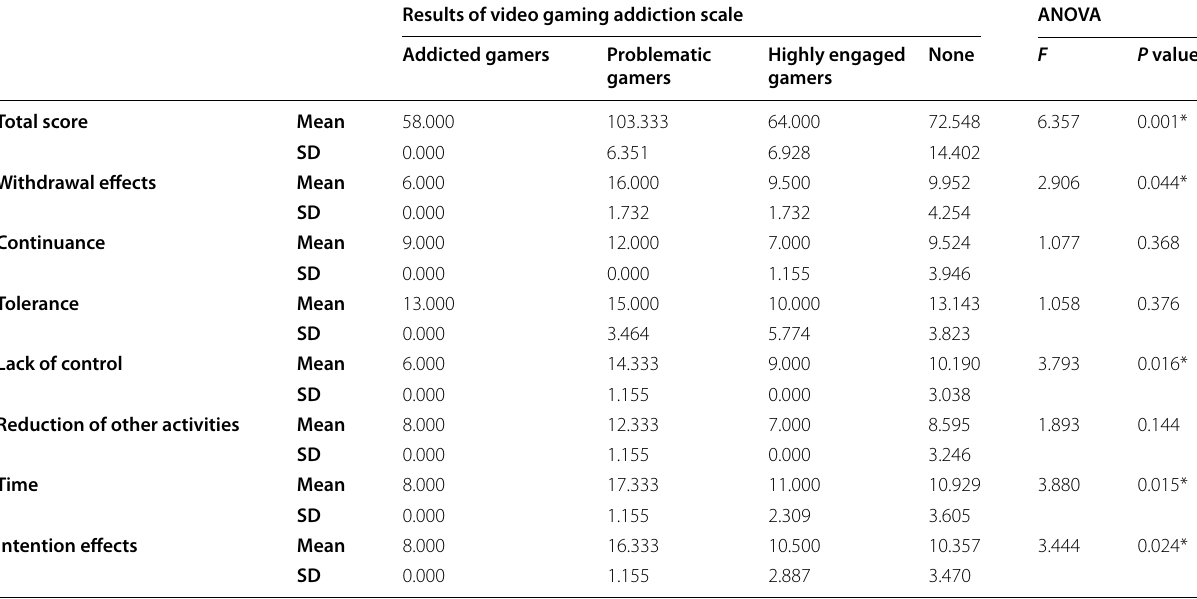
Table 9 Correlation between the different components of the “Exercise Dependence Scales‑21 Manual & video gaming addiction Results of video gaming addiction